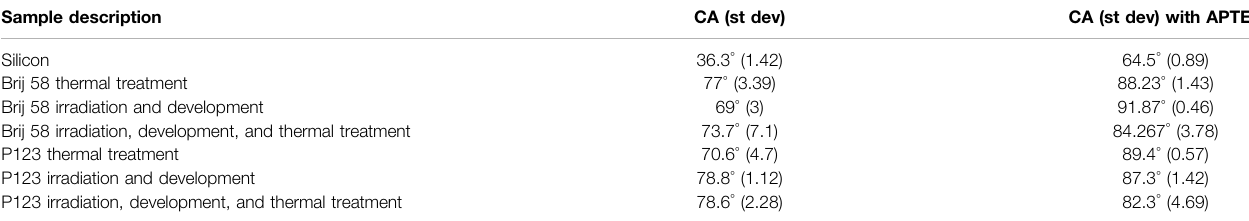
TABLE 2 | Contact angle (CA) of mesoporous materials prepared with two surfactants and subject to different treatments. Sample